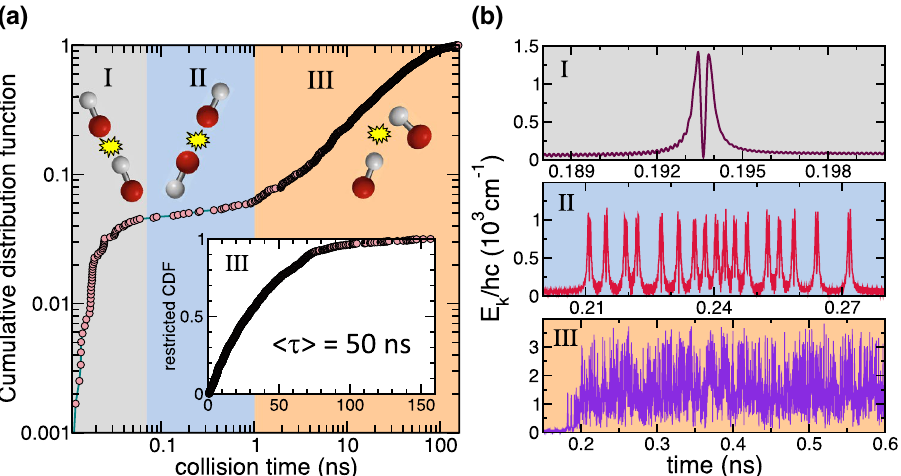
Figure 2. ( a ) Cumulative distribution function of the duration or collision time τ of the collisional complex in cold 23 Na 87 Rb+ 23 Na 87 Rb collisions determined from classical trajectory simulations starting with zero impact parameter. For each of the approximately 1200 trajectories the initial state is sampled assuming that the molecules are in the v = 0, J = 0 ro-vibrational ground state. Three classes of trajectories are observed. They are indicated with colored bands and the roman numerals I, II, or III. The inset shows the restricted cumulative distribution function for trajectories versus τ in class III. ( b ) Total kinetic energies E k as functions of time since the start of the simulation for one trajectory taken from each of the three classes. Figures were prepared using Microsoft Power Point for Mac version 16.47 and Grace-5.1.22